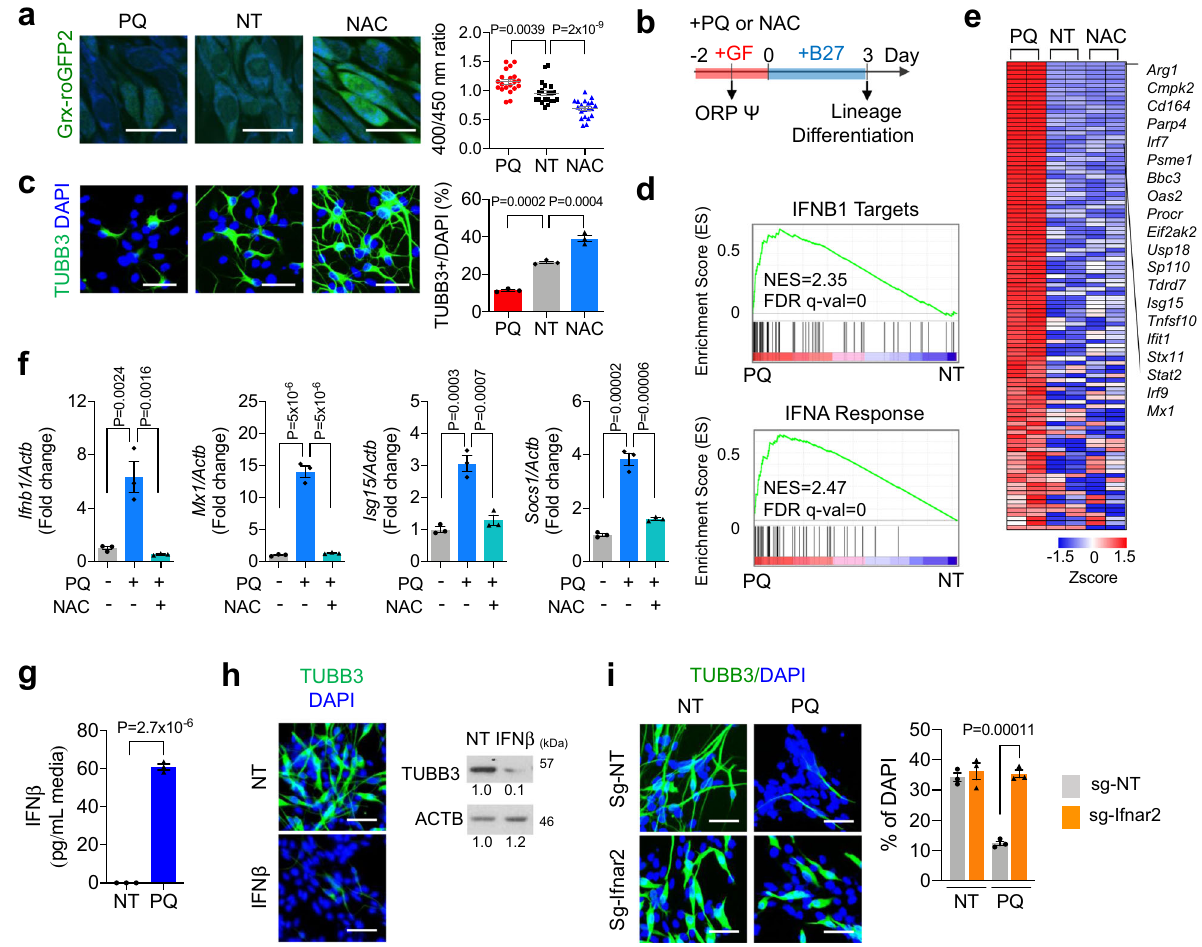
Fig. 1 Cellular stress response under high redox potential activates IFN-I responses. a Left, representative images of treated Grx1-roGFP2-NSPC. Right, quantitation for redox potential of Grx1-roGFP2-NSPC following 24 h treatment. Scale bar = 20 µ m. Mean ± s.e.m. of 20 cells. PQ: 5 µ M of paraquat, NT: mock-treated control, NAC: 5 mM of N-acetylcysteine. b Schema for treatment of NSPC culture. ORP: oxidation/reduction potential. c Representative immuno fl uorescence analysis (IF) images of TUBB3 on 3 day of differentiation. Scale bar = 50 µ m. Percent of TUBB3-positive cells is plotted on the